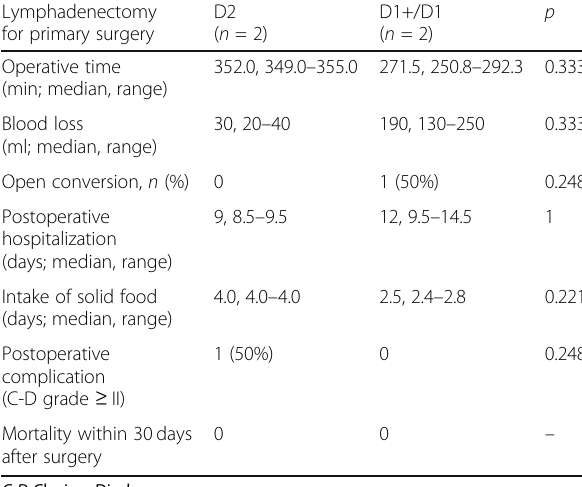
Table 5 Surgical outcomes in patients with the history of gastrectomy for gastric cancer as primary surgery in the LCG group Lymphadenectomy for primary